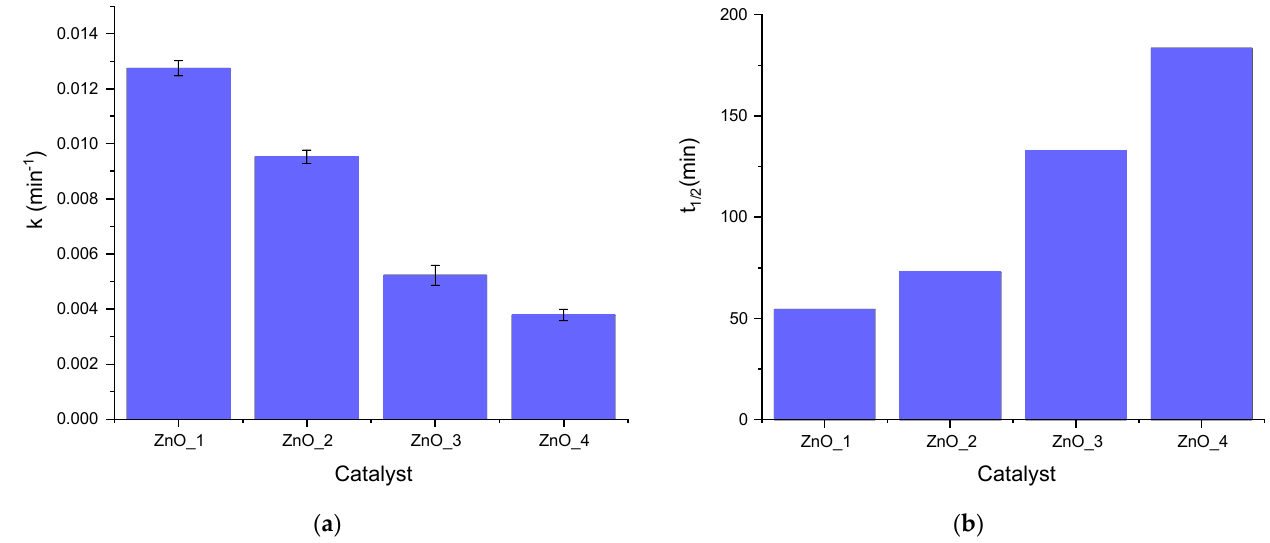
Figure 11. Pseudo-first-order rate constants ( a ) and half-life times ( b ) for MB photodegradation in the presence of synthesized ZnO samples (1.5 mg ZnO and 5 ppm MB).